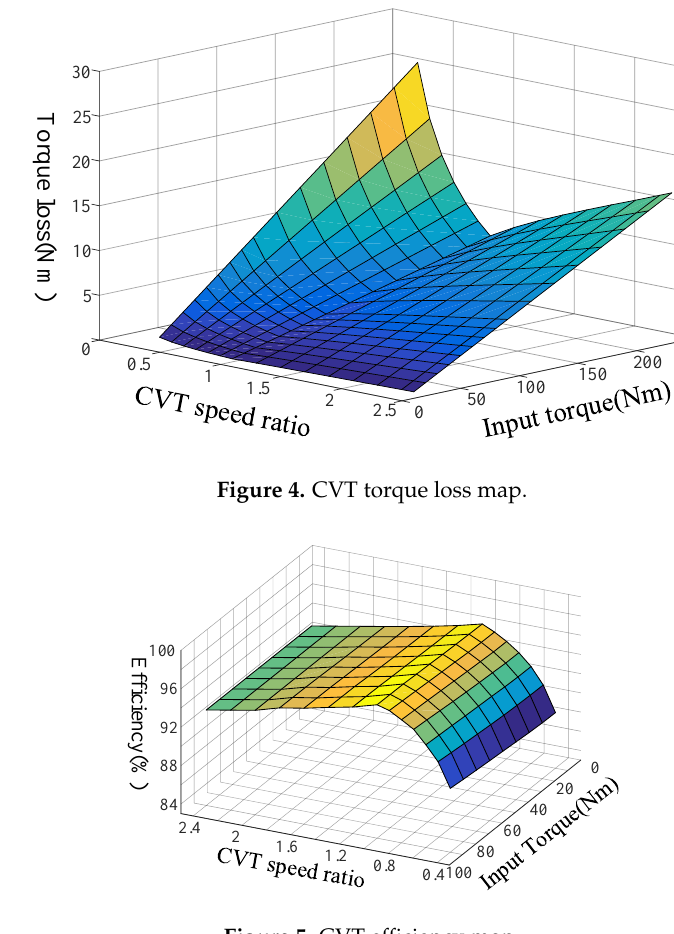
Figure 5. CVT efficiency map.